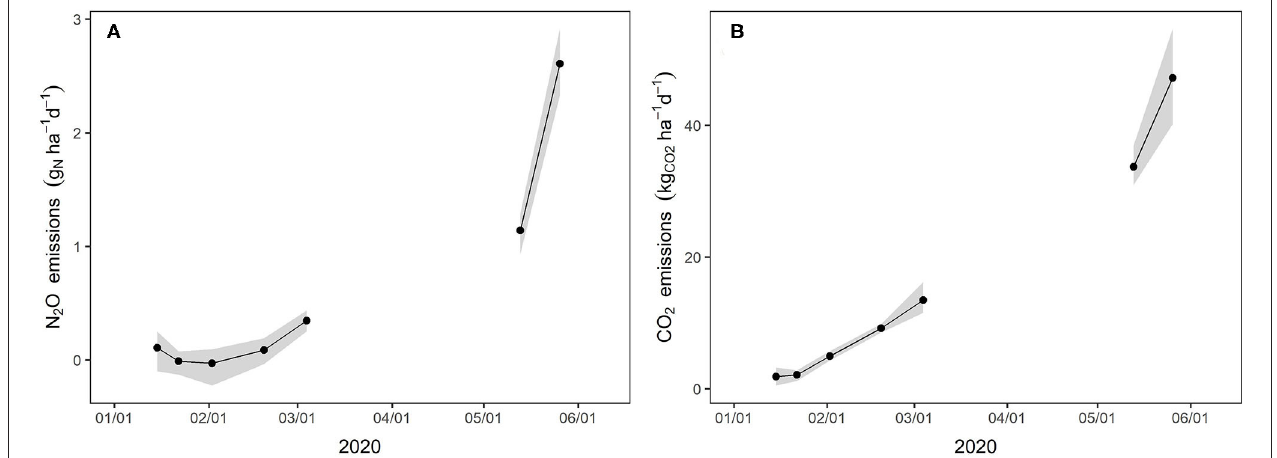
FIGURE 2 | N 2 O (A) and CO 2 (B) emission rates from the root zone of tomatoes grown on rock wool growing bags in a closed-loop hydroponic system in early 2020. Circles show mean values of n = 6 replicates and shaded areas the corresponding 95% confidence intervals. Sampling was restricted in March and April due to the COVID-19